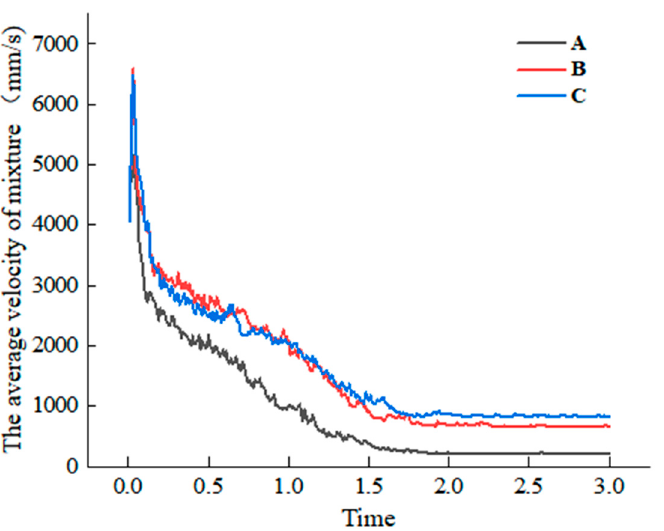
Figure 11. The relationship between the average velocity of mixture in the concentric threshing device and time: (A) single threshing gap of 15 mm; (B) single threshing gap of 10 mm; (C) multi-threshing gaps of 10 mm and 15 mm.